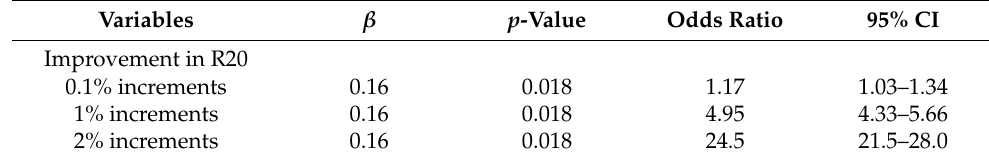
Table 3. Logistic regression results for factors associated with oral appliance treatment success.